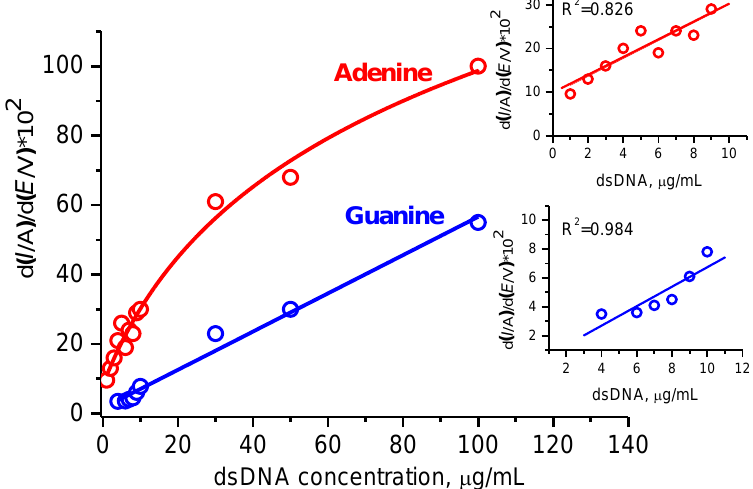
Figure 6. The dependences of the intensities of the di ff erentiated DPV peaks for electrooxidation of the guanine (blue) and adenine (red) residues for the di ff erent concentrations of dsDNA. Conditions: measurements were carried out with the SPE / (P n BMA 40 - b -PDMAEMA 120 + MWCNT_2) construct; the incubation time after dsDNA deposition was 60 min. First derivatives of the DPV raw data were used for calculating the given intensity values.